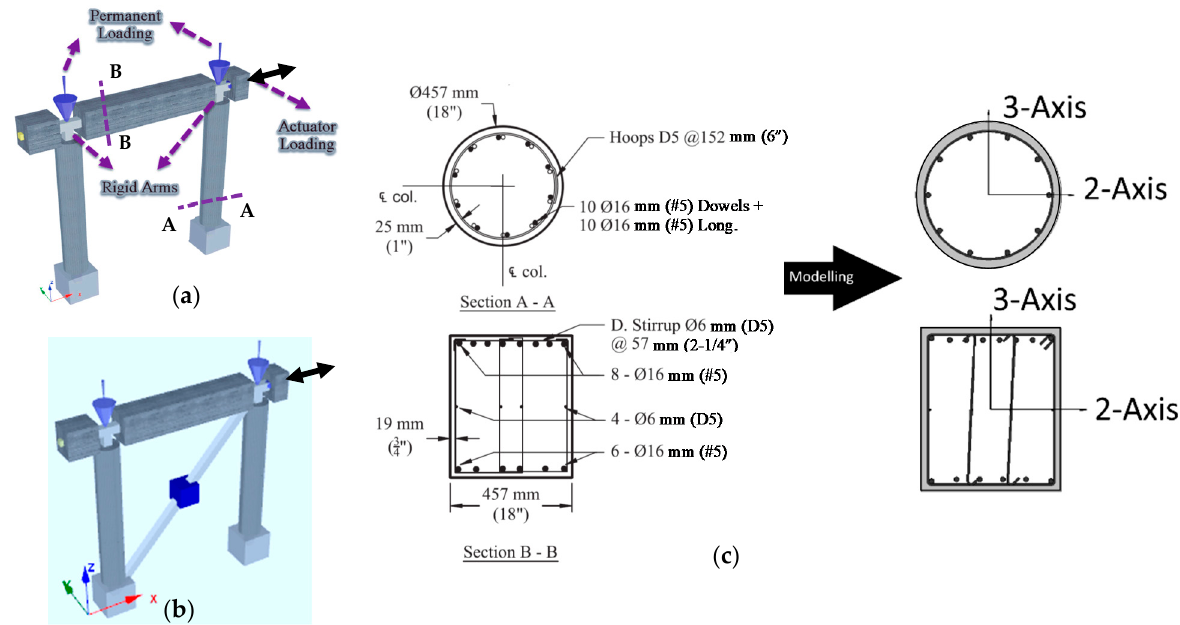
Figure 3. Idealizing of bridge bent for the verification of modeling approaches: ( a ) fiber-based model of existing bridge bent test specimen, ( b ) fiber-based model of retrofitted bridge bent with buckling restrained brace (BRB), and ( c ) modeling of the pier and cap beam sections.